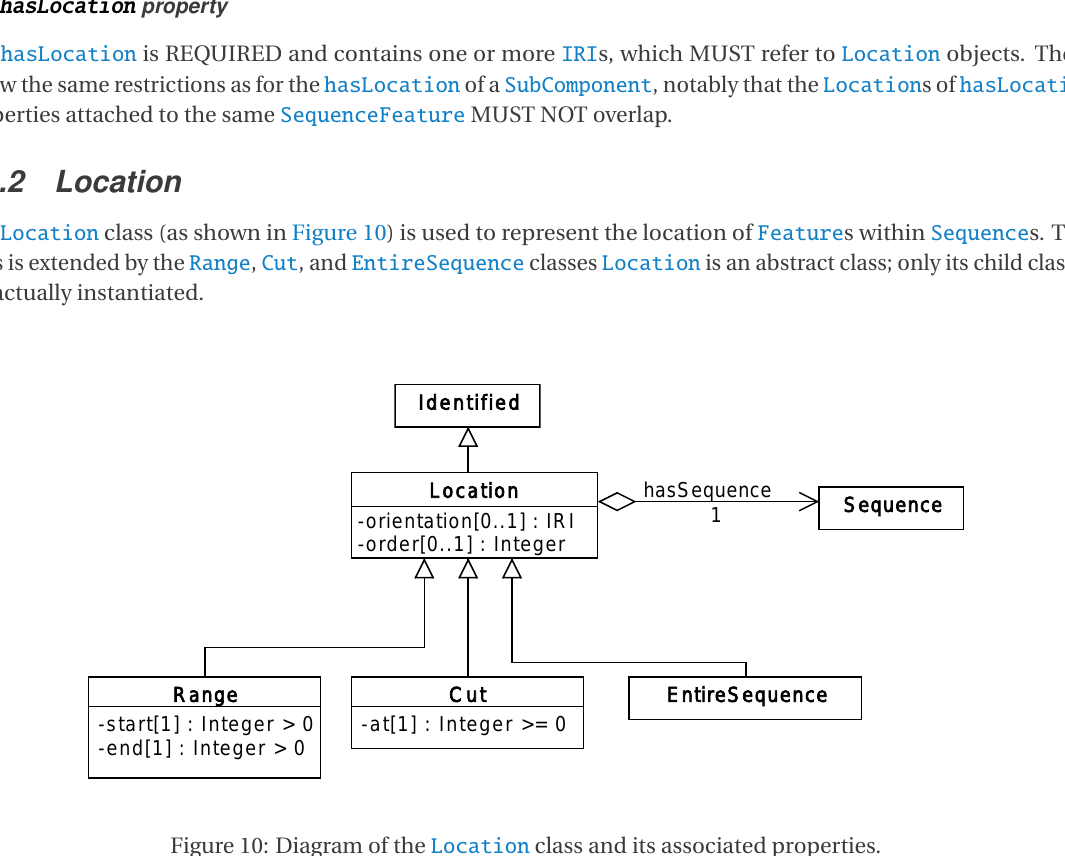
Figure 10: Diagram of the Location class and its associated